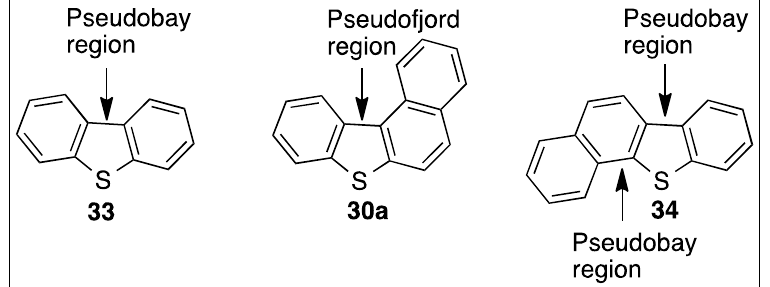
Figure 4. Identification of pseudo-bay and pseudo-fjord regions of polycyclic thiophenes.